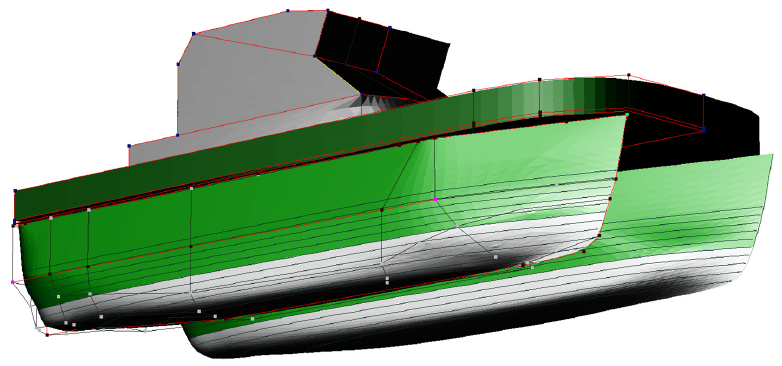
Figure 6. Geometric shape of the CTV hull as seen in FREE!ship [47].